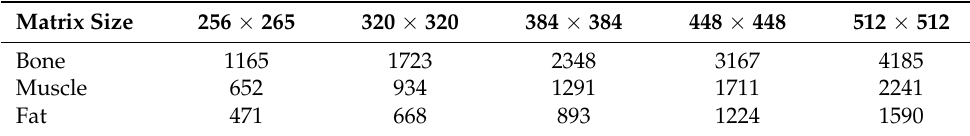
Figure 5. Position of ROIs used for analyzing different tissue types (bone: red; fat: blue; and muscle: green). Table 2. Average ROI sizes for various matrices [pixels].